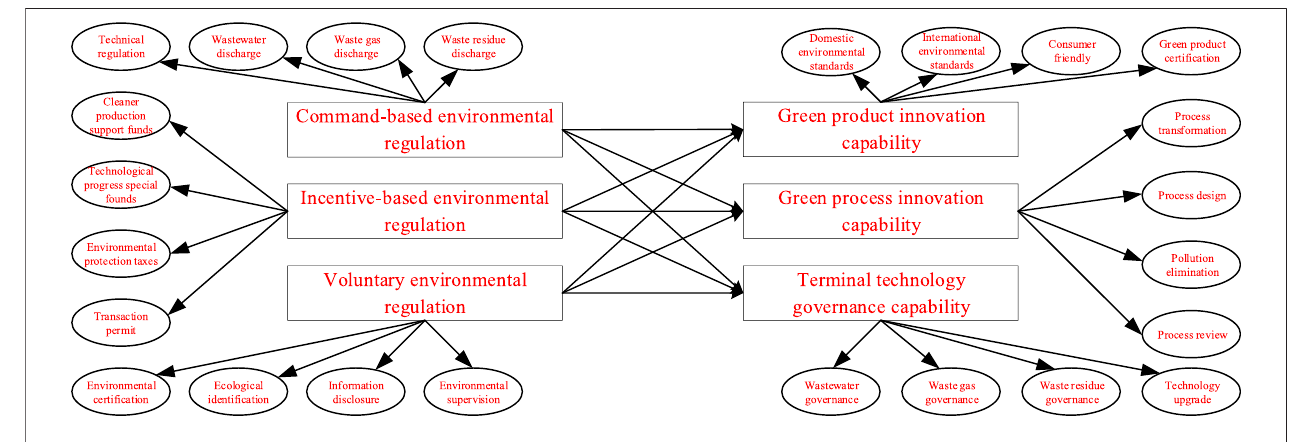
FIGURE 1 | Conceptual